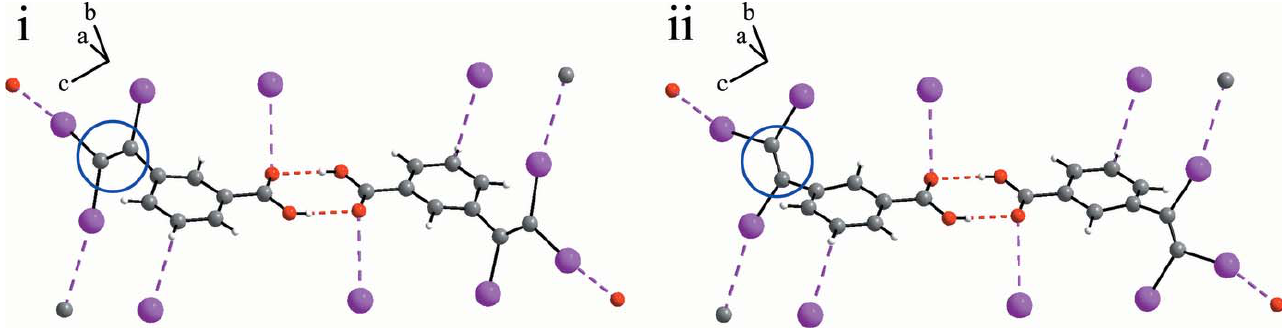
Figure 2 The crystal packing of 3-(1,2,2-triiodoethenyl)benzoic acid, showing O—H (cid:2)(cid:2)(cid:2) O hydrogen bonds and the C—I (cid:2)(cid:2)(cid:2) O and C—I (cid:2)(cid:2)(cid:2) C halogen bonds as dashed lines. The disorder positions in the ethenyl group are also indicated.